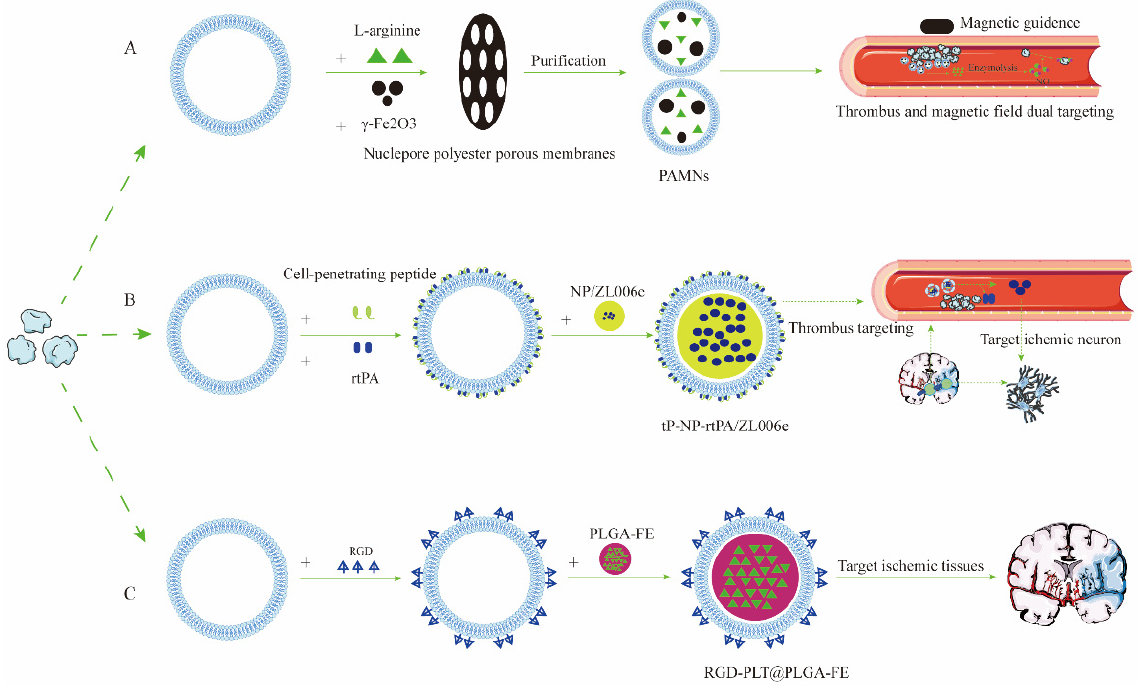
Figure 2. The preparation and characterization of platelet-cell-membrane coated nanoparticles for ND drug delivery. ( A ) The preparation and characterization of PAMNs for ischemic stroke drug delivery; ( B ) the preparation and characterization of tP-NP-rtPA/ZL006e for ischemic stroke drug delivery; and ( C ) the preparation and characterization of RGD-PLT@PLGA-FE for ischemic stroke drug delivery.